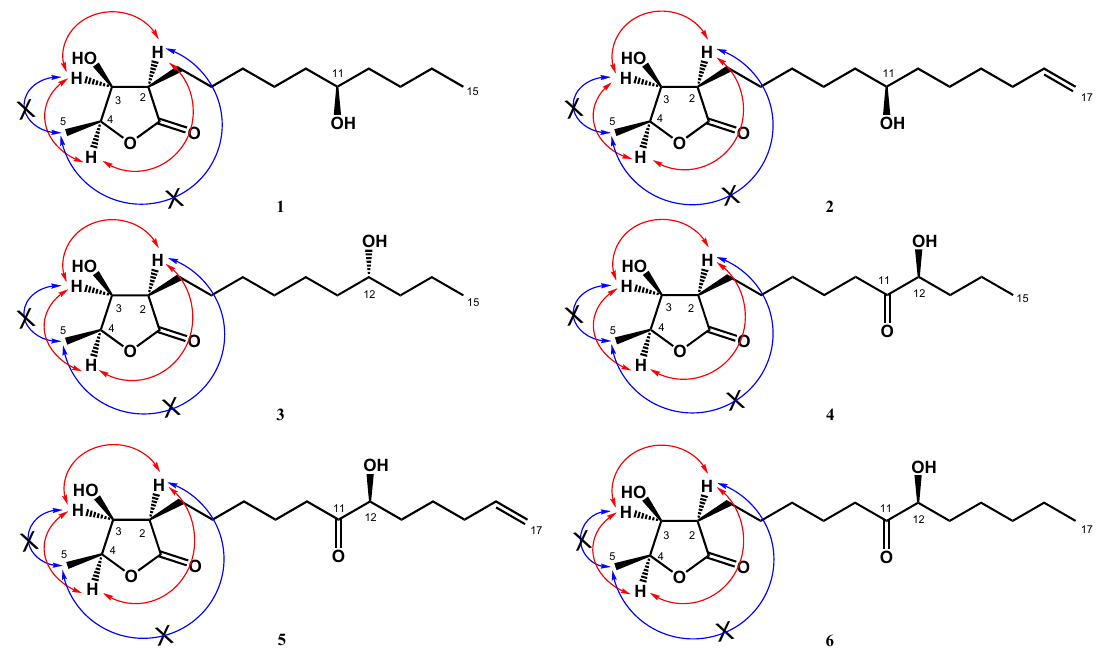
Figure 3. NOESY (H ↔ H) correlations of machinolides A–F ( 1 – 6 ).